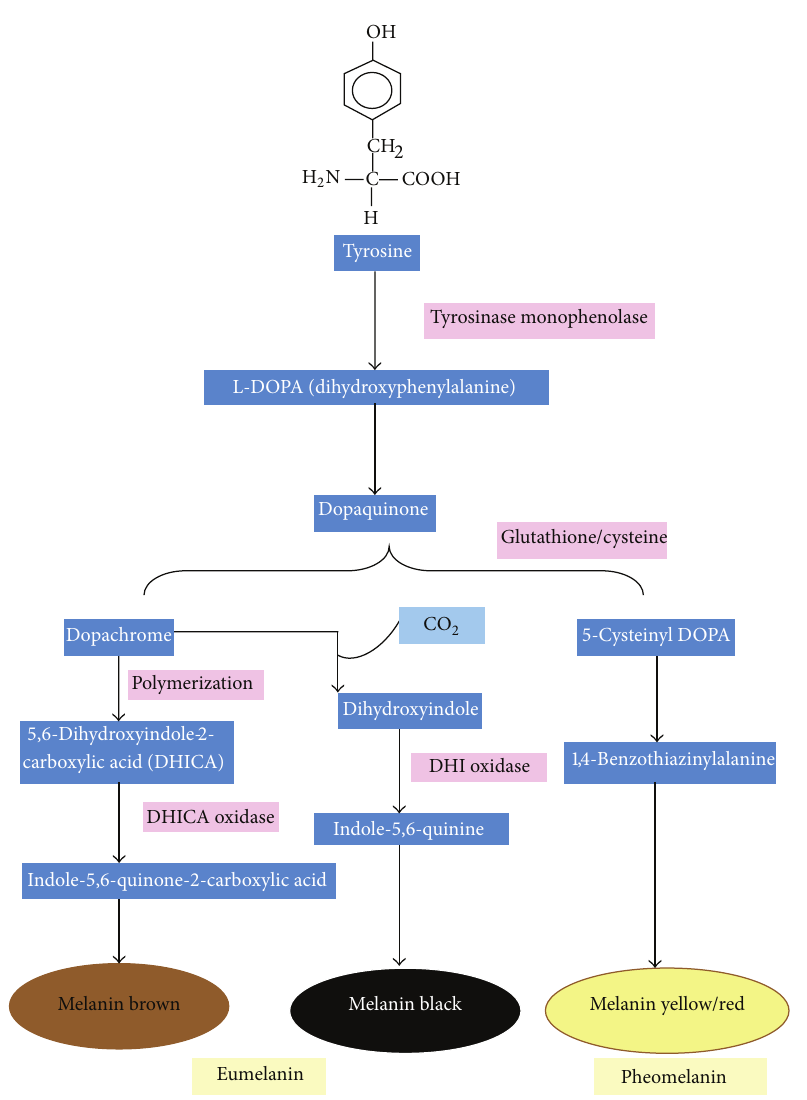
Figure 4: Production of different pigments by melanosomes.